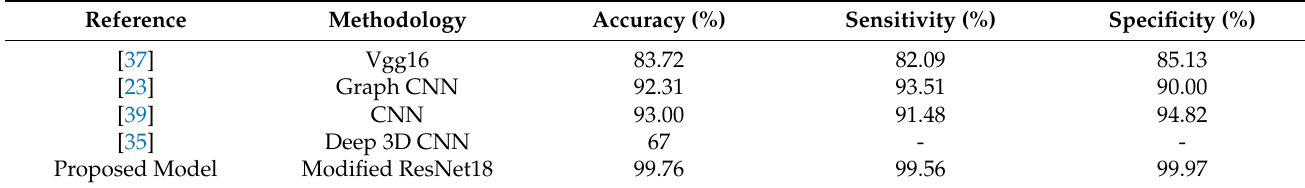
Table 11. Evaluation Results with the EMCI vs. LMCI Binary